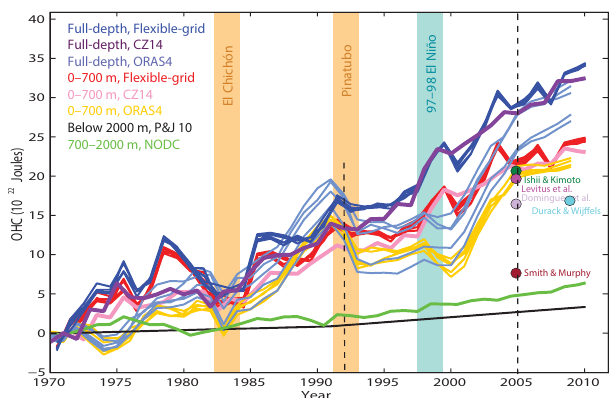
Figure 2. Observational ocean heat content from 1970 to 2010. The 0–700m OHC is shown in red (flexible-grid method), pink (CZ14 method), and yellow (ORAS4). Five adjusted OHCs presented in Durack et al. (2014) are shown as dots, which are the OHC changes per 35 years. The 700–2000m OHC is sourced from NODC in green, and abyssal (2000m–bottom) OHC is from Purkey and John- son (2010) and shown in black (the warming rate within 1970–1991 is scaled to 3 times the linear trend in Purkey and Johnson, 2010). Full-depth OHC time series are also presented in blue (flexible-grid method), dark purple (CZ14 method), and light blue (ORAS4). All of the time series are referred to a baseline OHC within the 3-year period: 1969–1971. The vertical colored bars are 2-year intervals, starting when the event (volcano or El Niño)